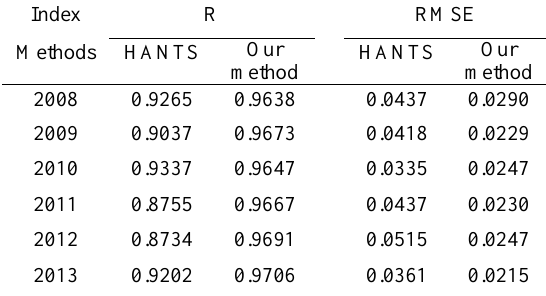
Table 3. The quantitative comparison of HANTS and our method.